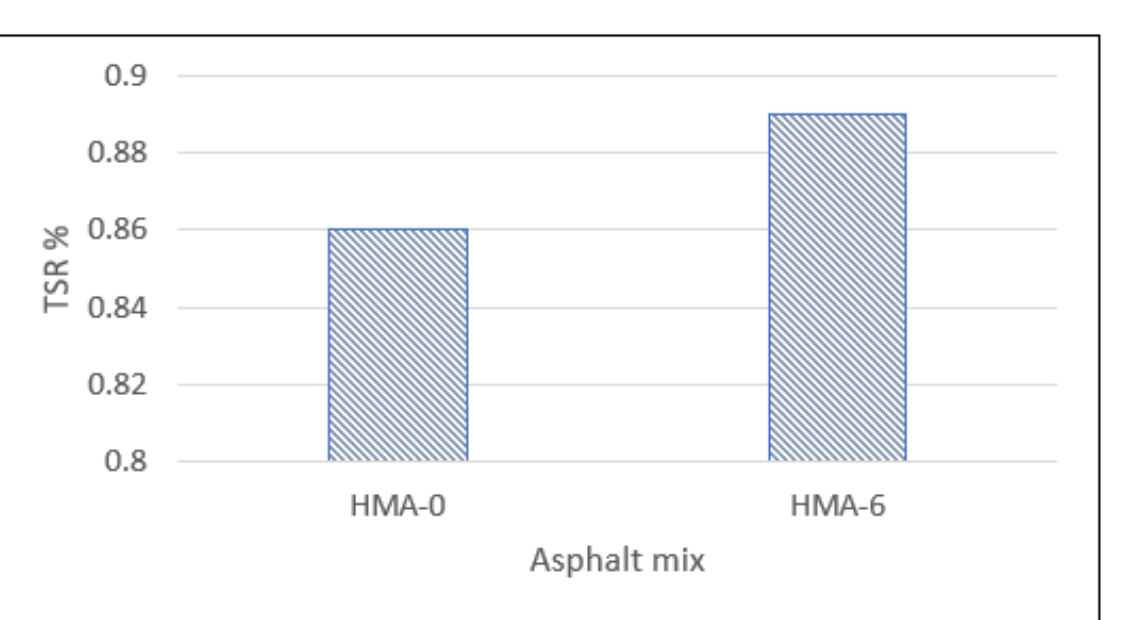
Figure 7. Resilient modulus ageing index of long-term aged mixes.